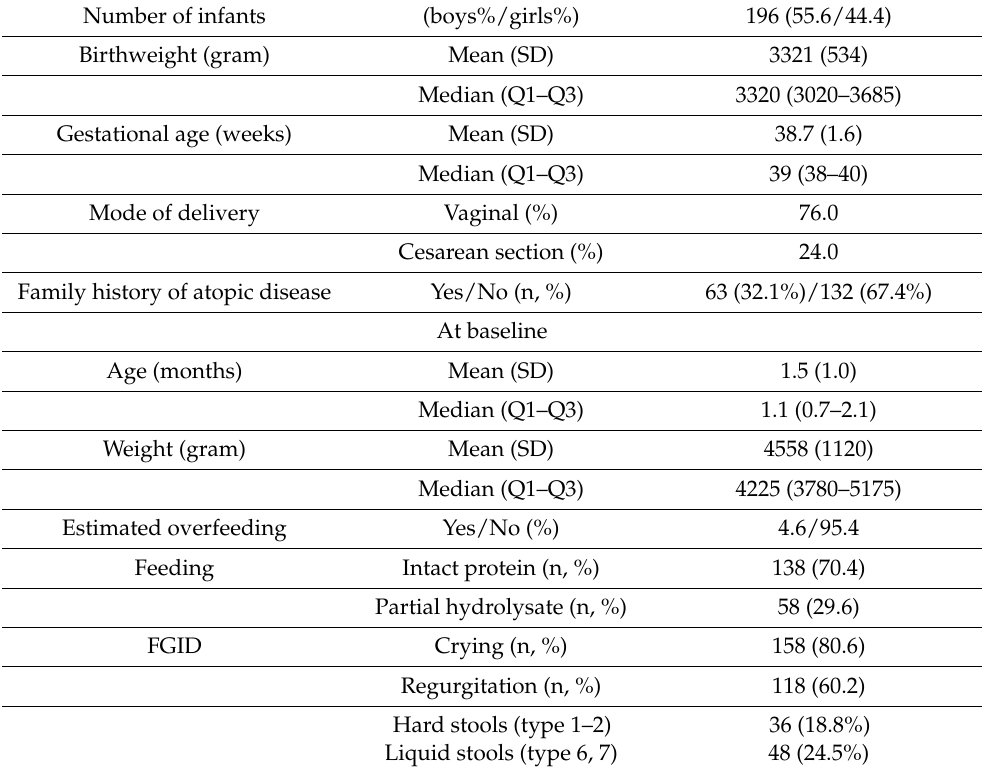
Table 3. Patient